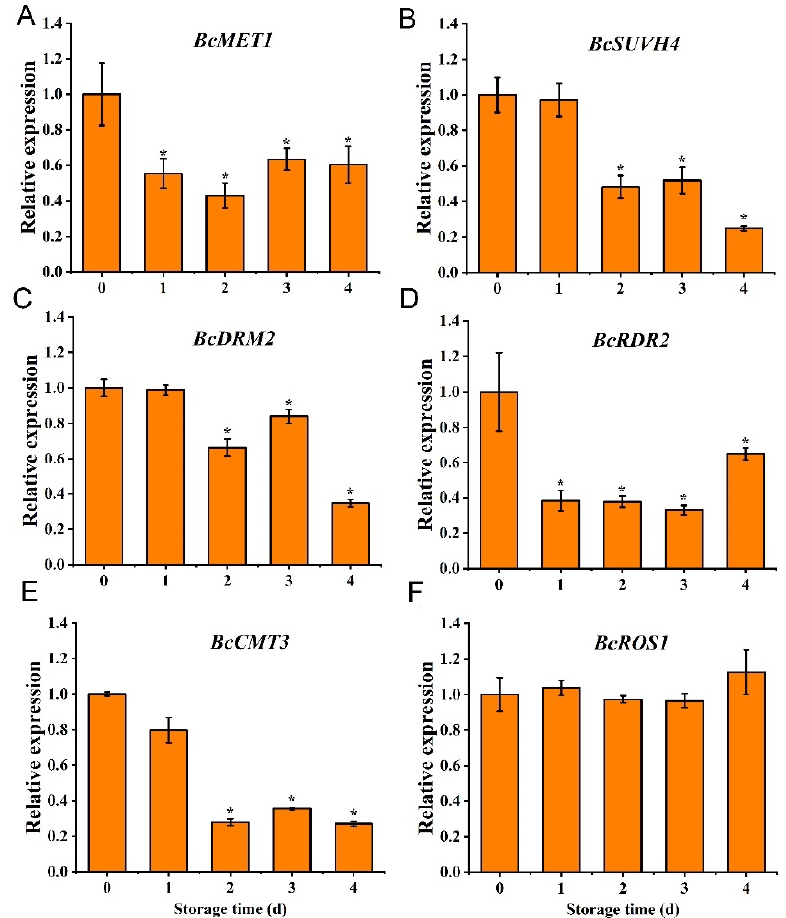
Figure 1. The expression of the DNA methyltransferase genes ( BcMET1 , BcSUVH4 , BcDRM2 , BcRDR2 , and BcCMT3 ) ( A – E ) and the demethyltransferase gene ( BcROS1 ) ( F ) in the control group during storage. The data in the figure are the mean ± SD of three biological replicates. The bar in the figure represents the standard deviation. The asterisks in the figure indicate significant differences between the mean values expressed for different storage days in the control group (* p < 0.05).